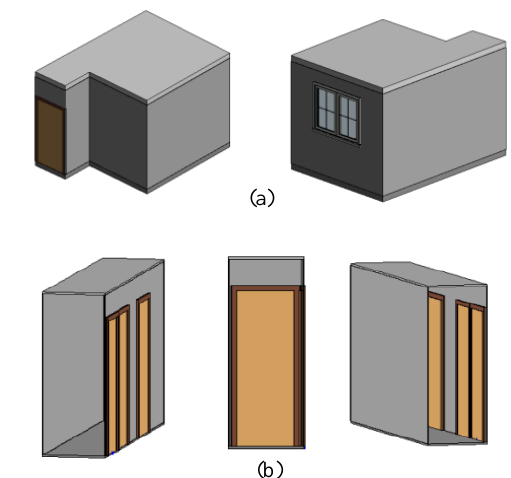
Figure 27. Results of 3D modeling for the room (a) and the corridor